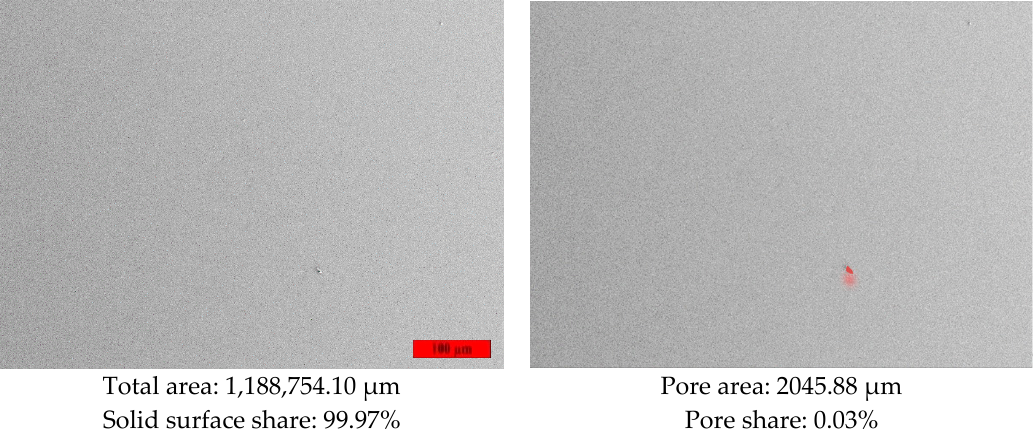
Figure 13. Results of measuring the share of pores for specimens of the Ti6Al4V casting alloy after milling in a CNC milling centre.